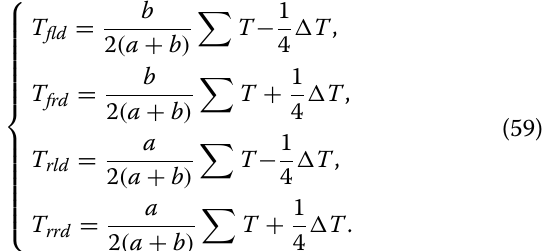
Figure 10 Simulation results of total power consumption